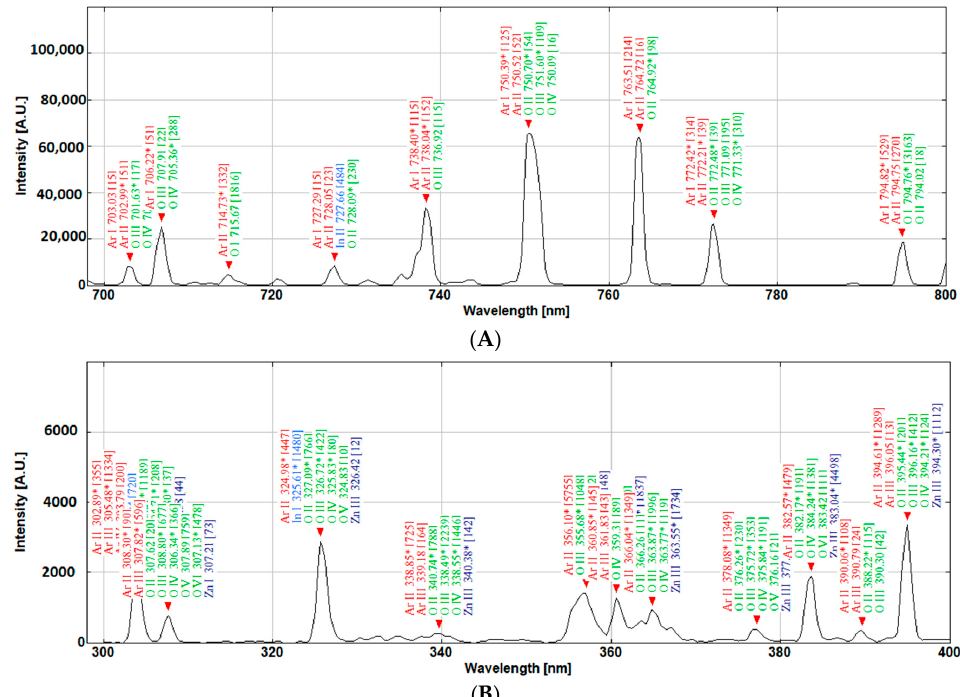
Figure 12. The emission spectrum and the associated Argon, Indium, Zinc and Oxygen states within far infra-red ( A ) and the UV section ( B ) of the spectrum obtained from the sputtering plasma. These regions are not accounted for when the chromaticity indices are calculated through the colour functions.